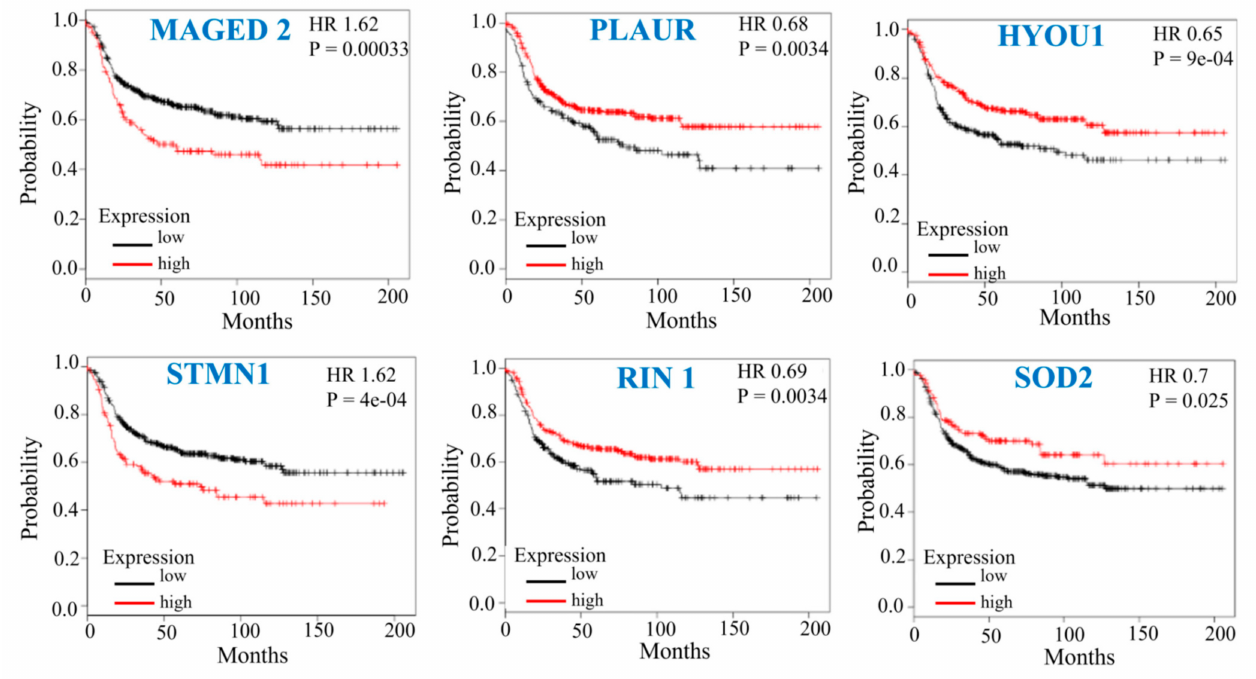
Figure 6. Prognostic implication of the selected top differential expressed protein in mdig KO vs. WT MDA-MB-231 cells. Top differentially expressed proteins ( p < 0.05, n = 8, moderated t -test) as revealed by the proteomics study were evaluated for their prognostic significance in breast cancer. Survival curves were plotted for TNBC patients ( n = 618) for the indicated proteins using Kaplan–Meier Plotter. X axis shows time in months and Y axis shows the overall survival